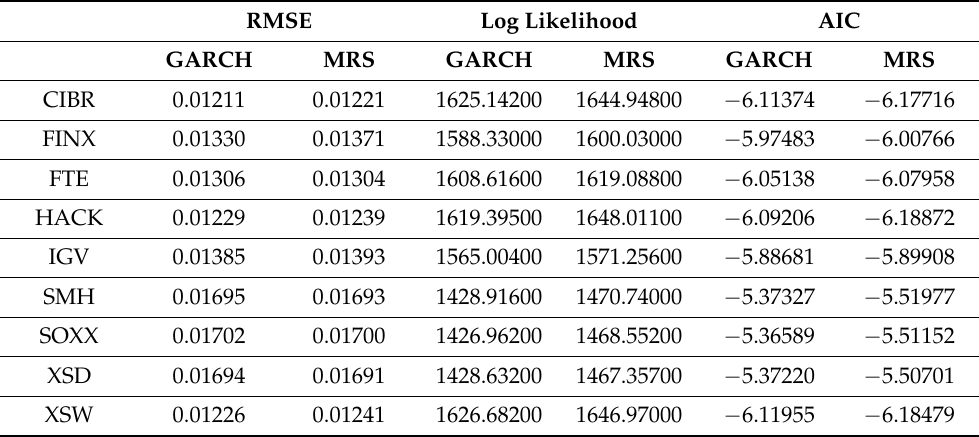
Table A11. Comparing GARCH vs. Heteroscedastic MRS, root mean square error (RMSE), Log Likelihood, AIC for Idiosyncratic Risk vs.